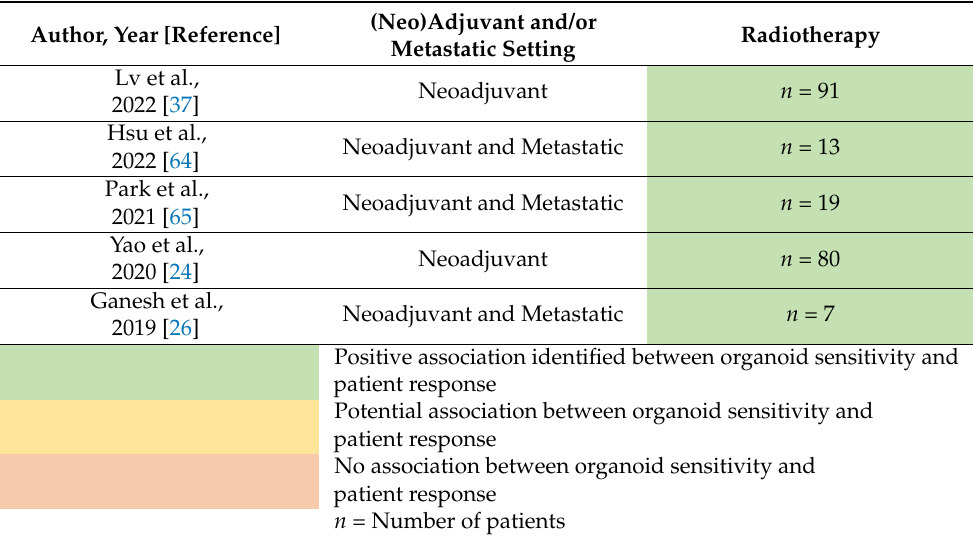
Table 3. Summary of studies associating organoid sensitivity and patient response to